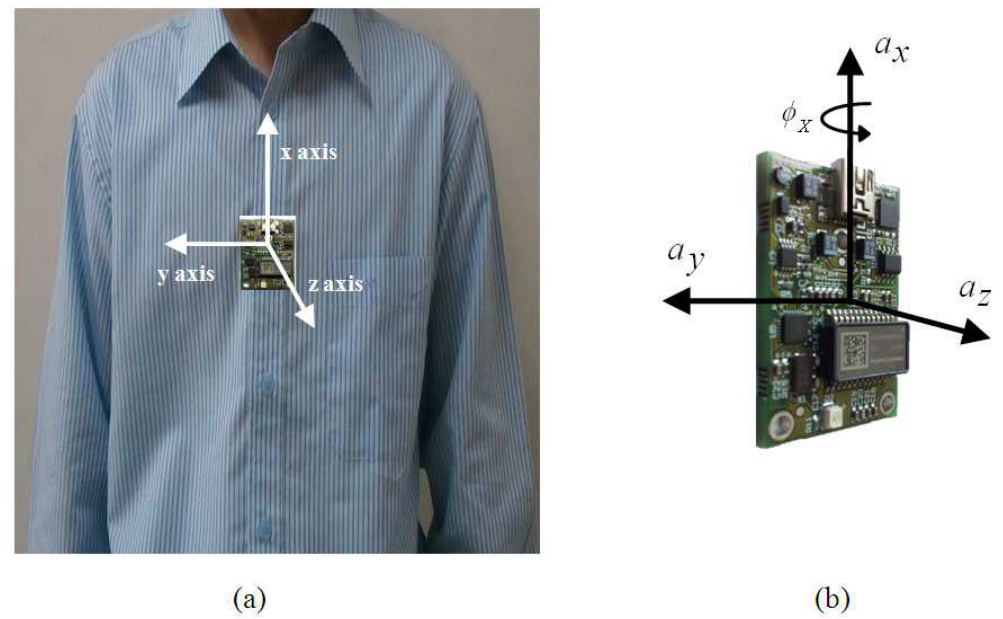
Figure 2. The experimental setup for MEMS sensor: ( a ) A MEMS sensor tagged on the subject’s chest; ( b ) Three axes of MEMS accelerometers for experimental